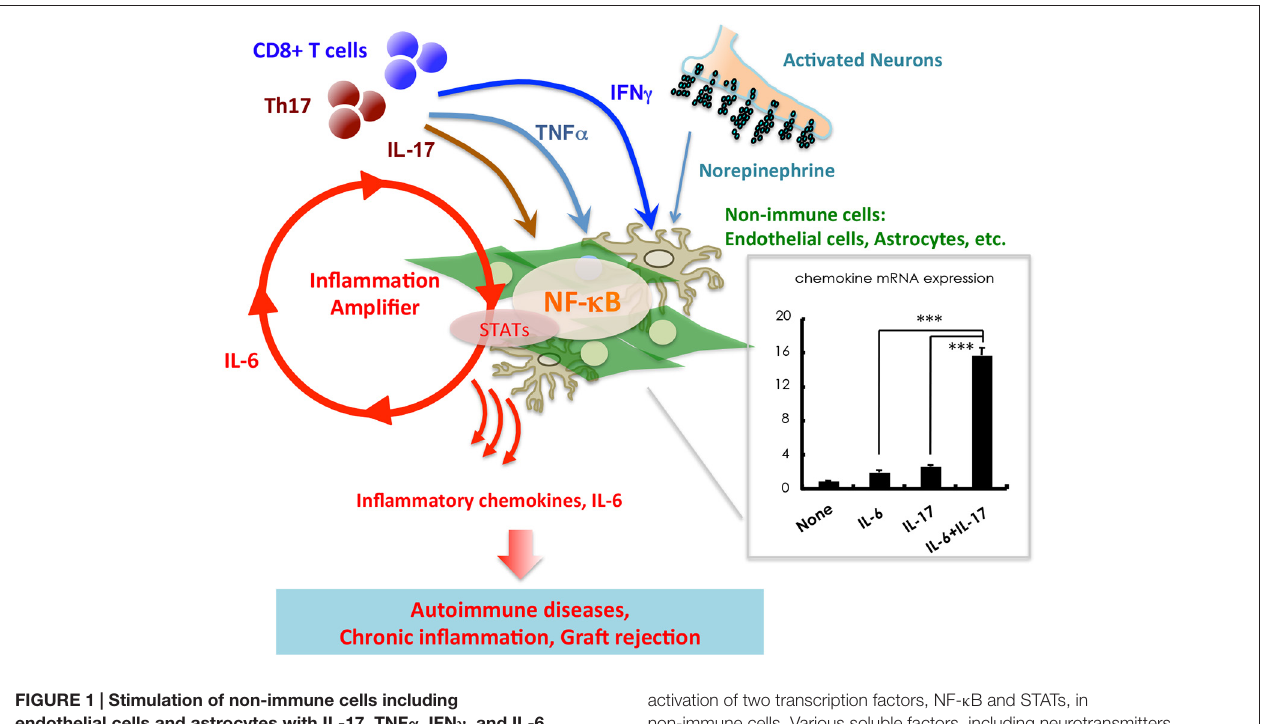
FIGURE 1 | Stimulation of non-immune cells including endothelial cells and astrocytes with IL-17, TNF α , IFN γ , and IL-6 from T cells induces a synergistic effect on the production of inflammatory chemokines such as CCL20 and IL-6. An imaginary figure is shown. The synergistic effect requires the simultaneous